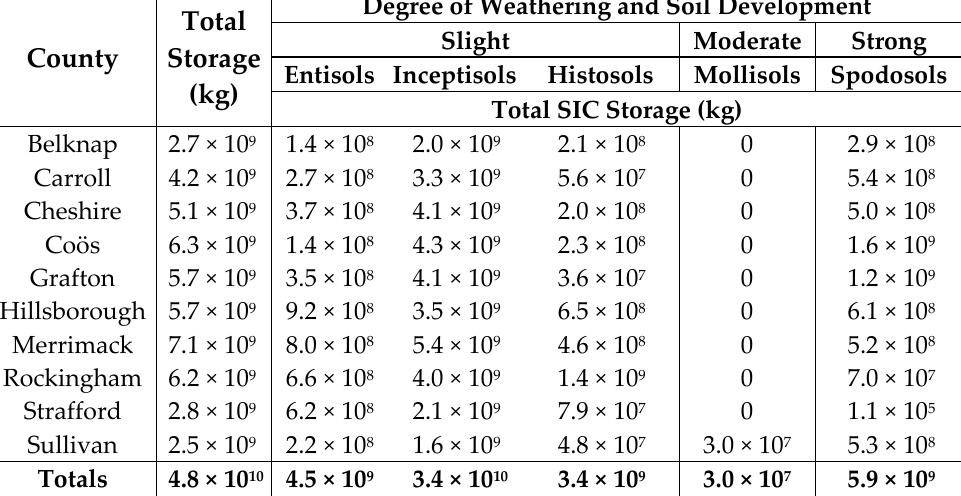
Table 7. Midpoint soil inorganic carbon (SIC) storage by soil order and county for the state of New Hampshire (USA), based on the areas shown in Table 3 and the midpoint SIC contents shown in Table 4.